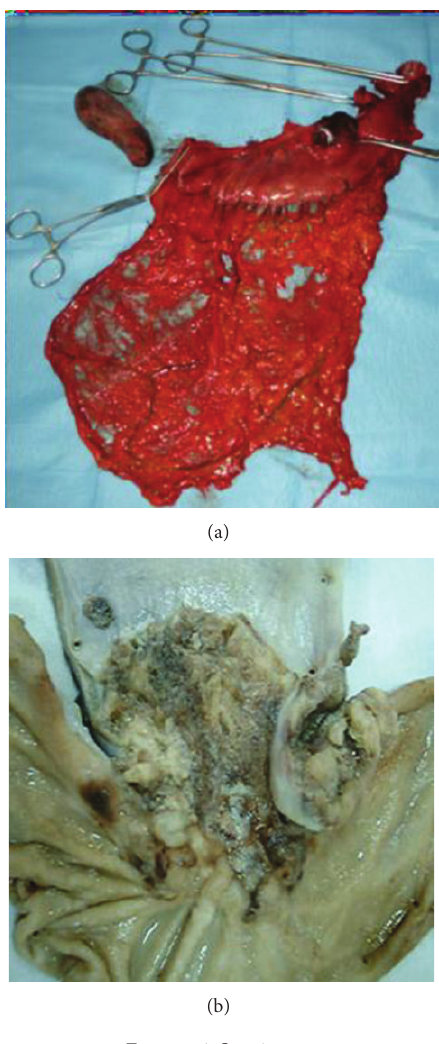
Figure 6: Specimens.